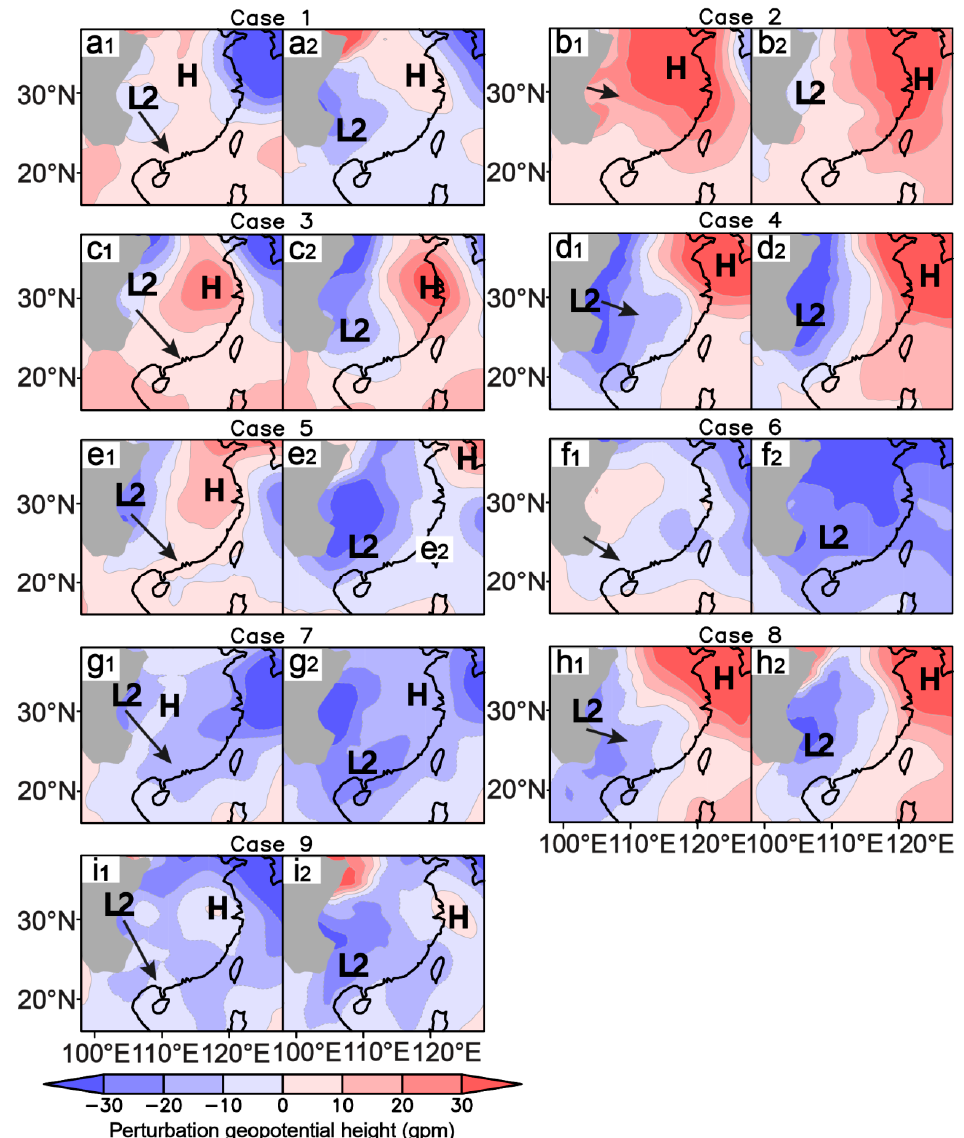
Figure 10. Evolution of 850-hPa SSTA-GH (color-shaded; units: gpm) on the east side of Tibetan Plateau (gray-shaded) ( a – i : cases 1–9; a 1 – a 2 : 0800–2000 BT 11 April 2012; b 1 – b 2 : 2000 BT 5–0800 BT 6 April 2014; c 1 – c 2 : 0800–2000 BT 8 May 2014; d 1 – d 2 : 2000 BT 22–0800 BT 23 May 2014; e 1 – e 2 : 1400